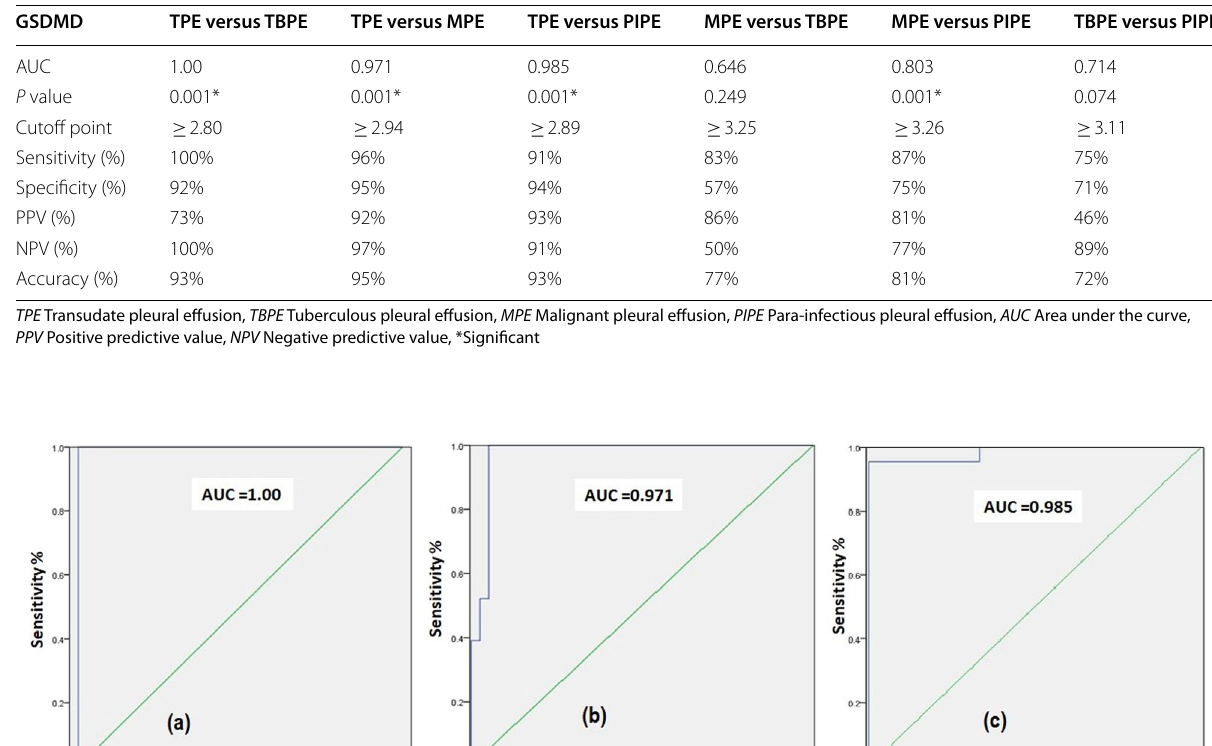
Table 5 Diagnostic accuracy of GSDMD in the differential diagnosis of pleural effusion